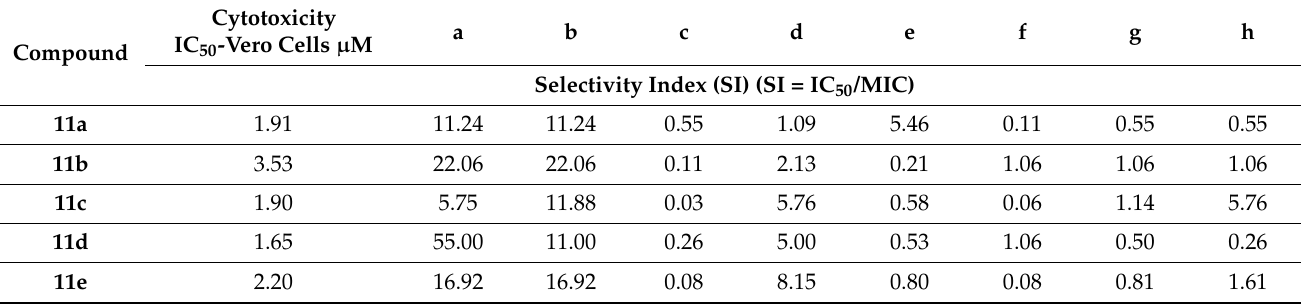
Table 10. Cytotoxic activity (IC 50 ) in Vero cells and selectivity index (SI) of the active synthetic hybrids 11a – e strains of M. tuberculosis